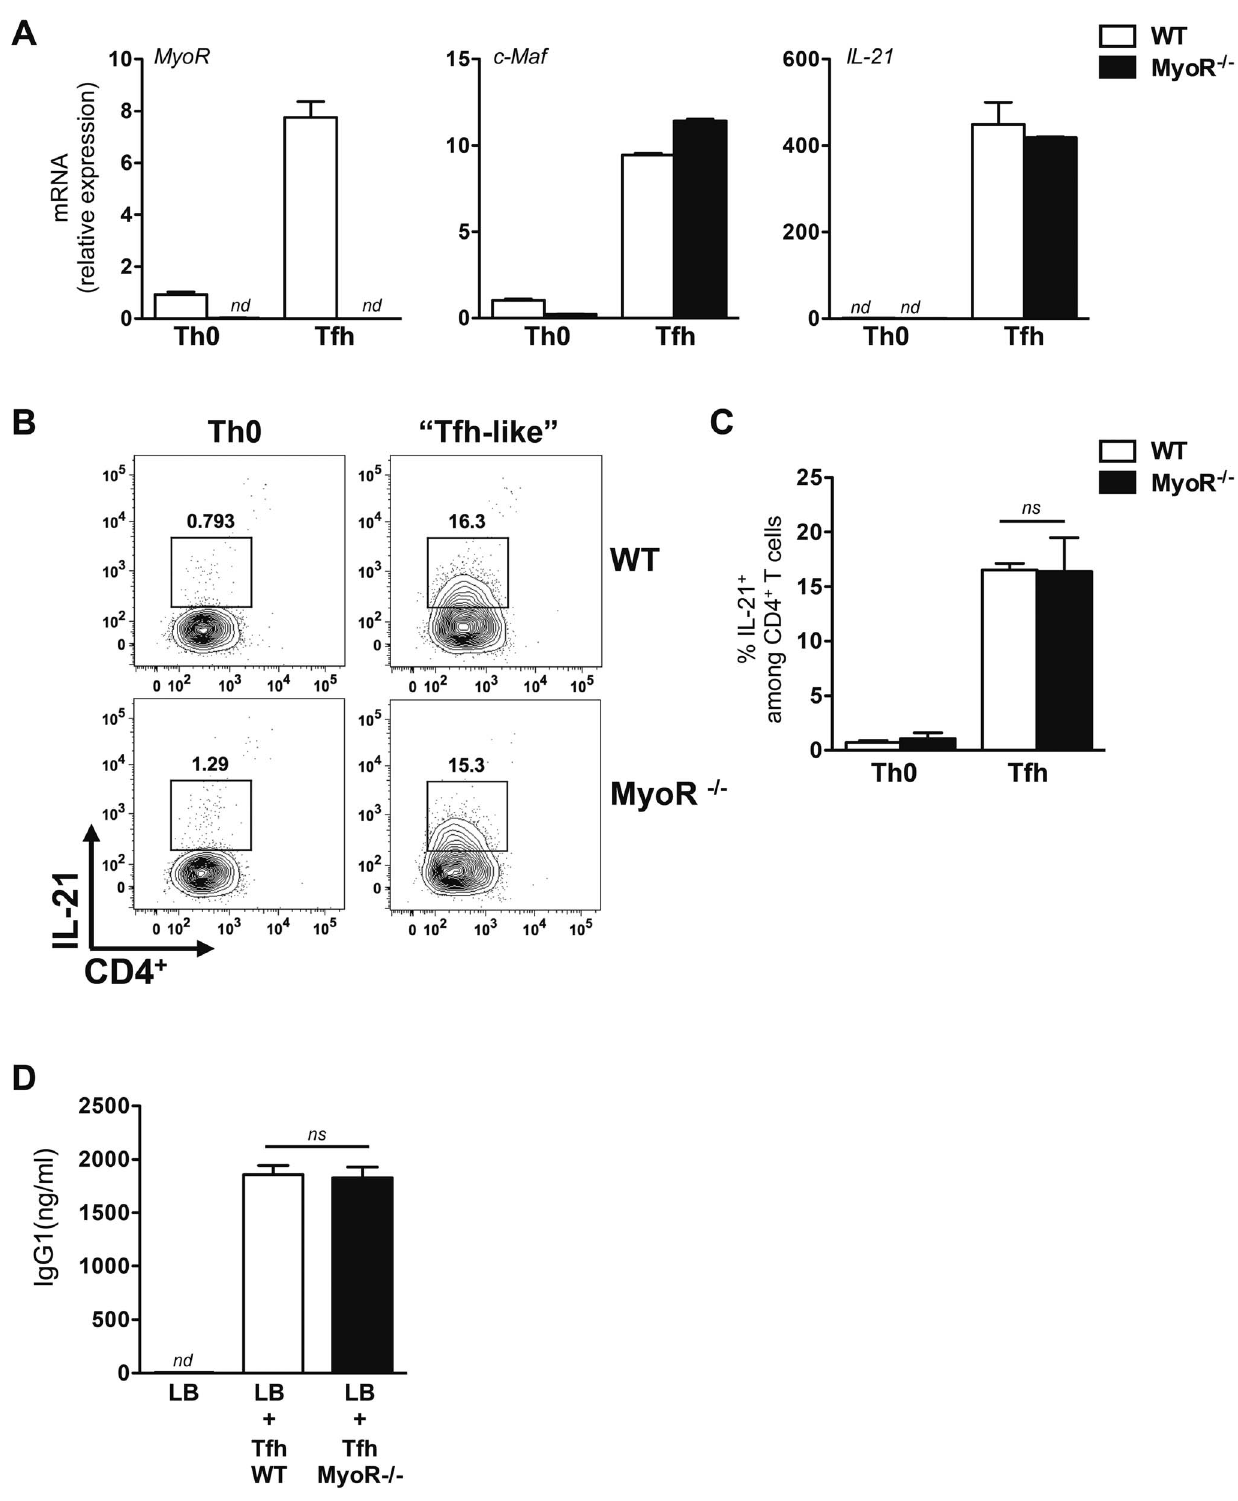
Figure 3. MyoR is not required for Tfh-like cells differentiation invitro . (A–C) Naive CD62L + CD4 + T cells purified from WT and MyoR 2 / 2 mice were cultured for 72 h under Th0 and Tfh culture conditions. Expression level of the indicated genes was assessed by quantitative RT-PCR and expressed as relative expression to RPL32 mRNA (A) Aliquots of cells were stimulated for 4 h with PMA and ionomycin and tested for IL-21 production by intracellular staining. Numbers indicate the percentage of IL-21 + in each panel (B). Histograms in (C) represent the mean 6 SD of IL-21 + cells from two independent experiments; (D) In vitro-derived Tfh-like cells from WT and MyoR 2 / 2 mice (1,6 6 10 4 cells/well) were irradiated and incubated with freshly purified naive B cells from C57BL/6 mice (5 6 10 5 cells/well) and anti-CD3 mAbs (5 m g/ml). Culture supernatants of T/B cells were tested on day 7 for IgG1 content by ELISA. Results are expressed as mean of triplicates cultures 6 SD and are representative of two independent experiments. Data are representative of at least two independent experiments with similar results. ns, not significant; nd, not detectable doi:10.1371/journal.pone.0084415.g003 PLOS ONE |